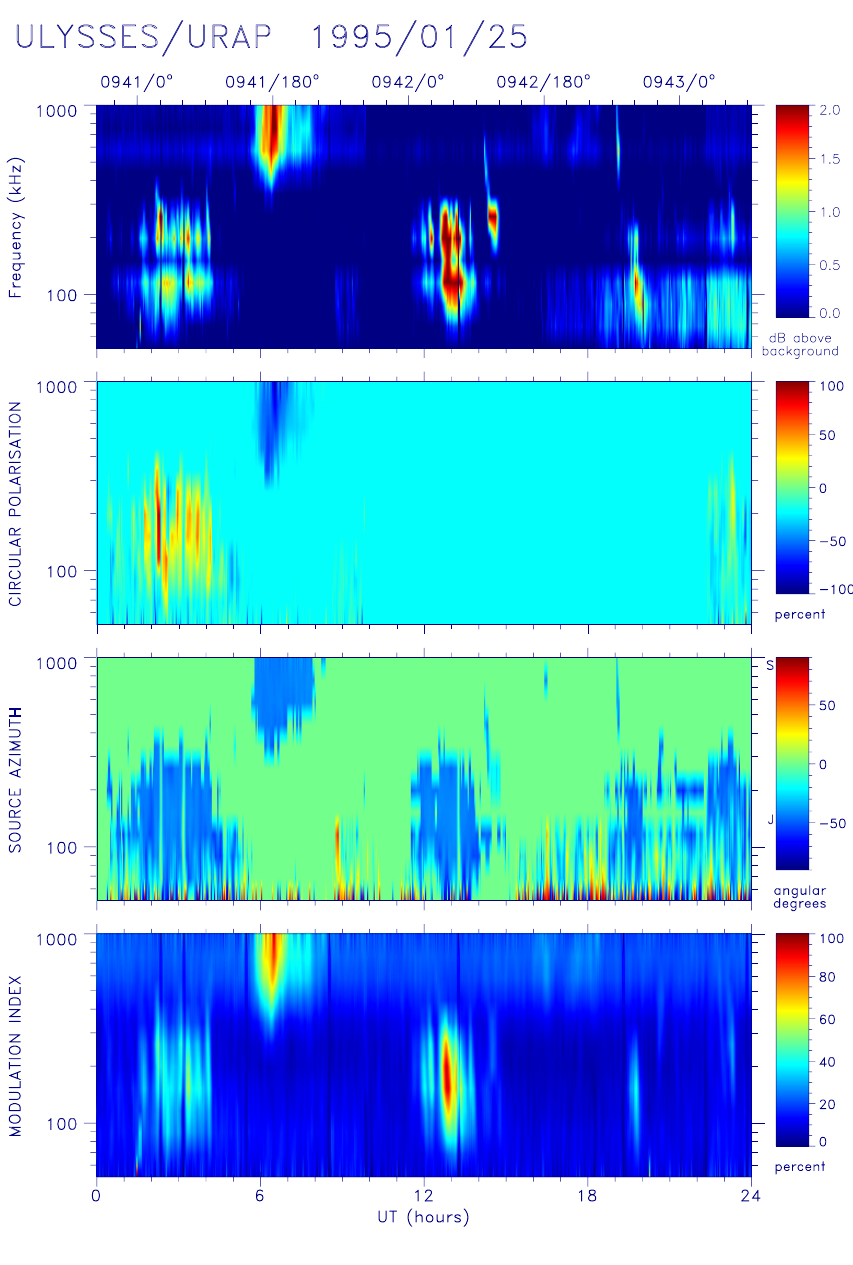
Fig. 3. Ulysses/URAP hi-band spec- tra for 950125 (DOY 94390). The four panels, from top to bottom, show spec- tra of total intensity, degree of polariza- tion, azimuth of the direction of origin of the emission with respect to the di- rection of the Sun and modulation in- dex. The numbers along the top of the first spectrum give the jovian ro- tation number (zero on 820101) and CML values, corrected for the light- travel time from Jupiter to the space- craft. The HOM event beginning close to 06:00UT is RH, while a bKOM event beginning at about 01:00UT is